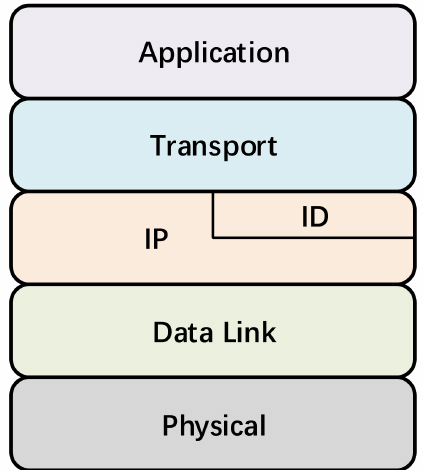
Figure 2. The protocol stack of IP-compatible ICN